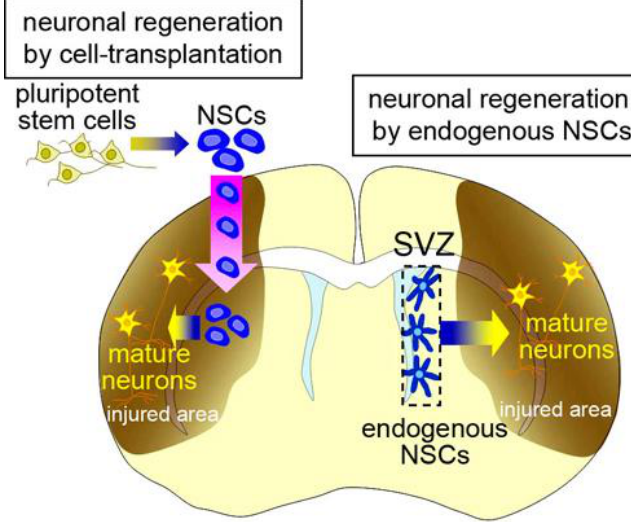
Figure 1. Therapeutic strategies using exogenous and endogenous neural stem cells (NSCs). Schematic drawing of a model for the therapeutic use of exogenous (left) and endogenous (right) NSCs. Exogenous NSCs derived from pluripotent stem cells including embryonic stem cells (ESCs) and induced-pluripotent stem cells (iPSCs) are transplanted into the damaged brain, and differentiate into mature neurons to replace damaged